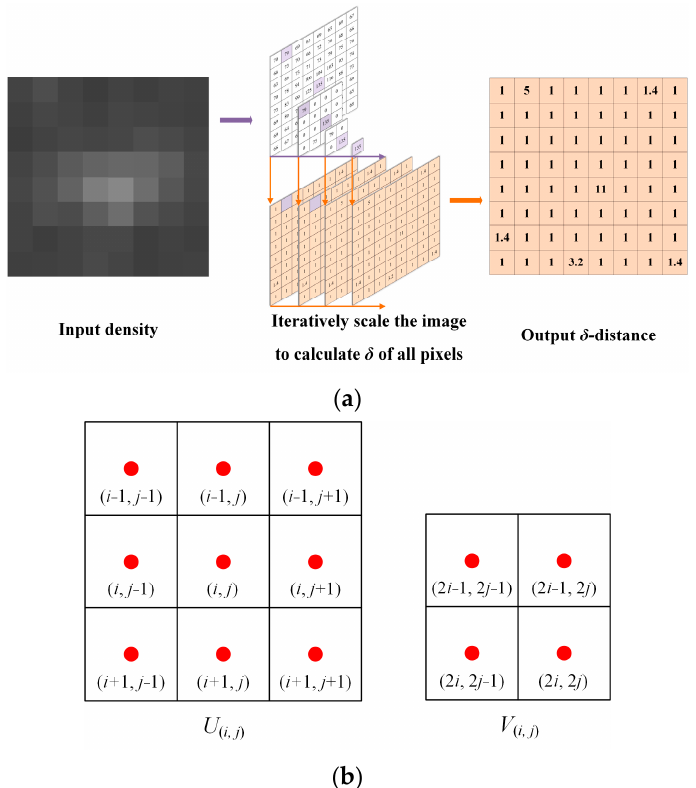
Figure 4. A strategy for quickly computing δ -distance. ( a ) Schematic diagram; ( b ) Regions denoted by U ( i , j ) and V ( i , j ) .